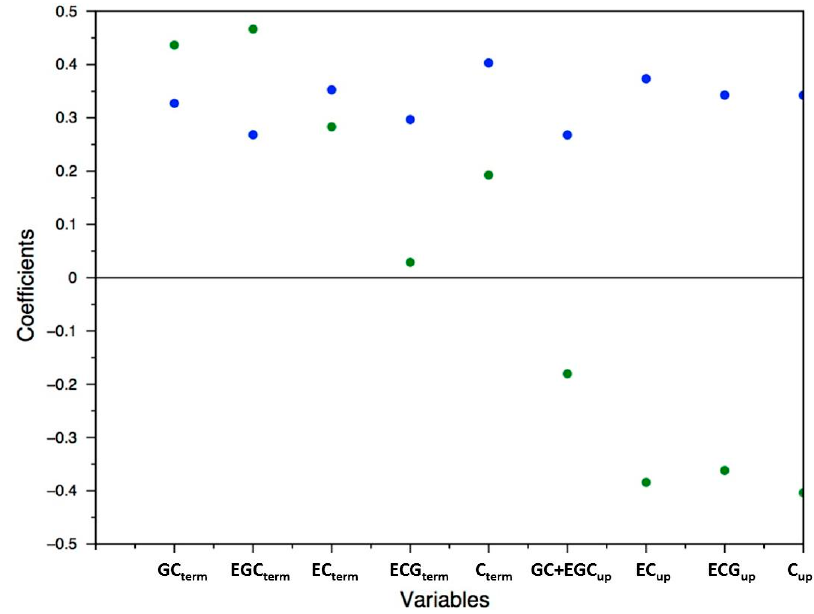
Figure 5. Projection of the variables on the first two principal components, PC1 ( ● ) and PC2 ( ● ), of the PCA performed on the skin flavan-3-ol composition data mg/g berry skin; centered reduced data).